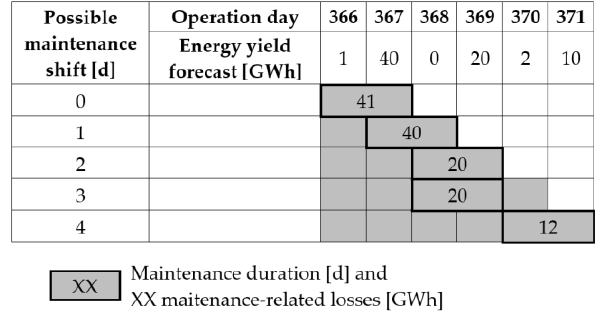
Figure 8. Possible maintenance shift from 0 to 4 days.